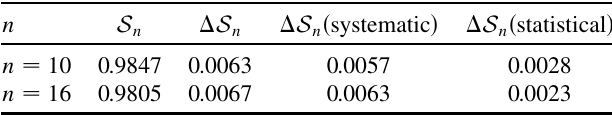
TABLE IV. Size of systematic and statistical error factors contributing to (cid:4) S n (Fig. 4 data) with 1-km